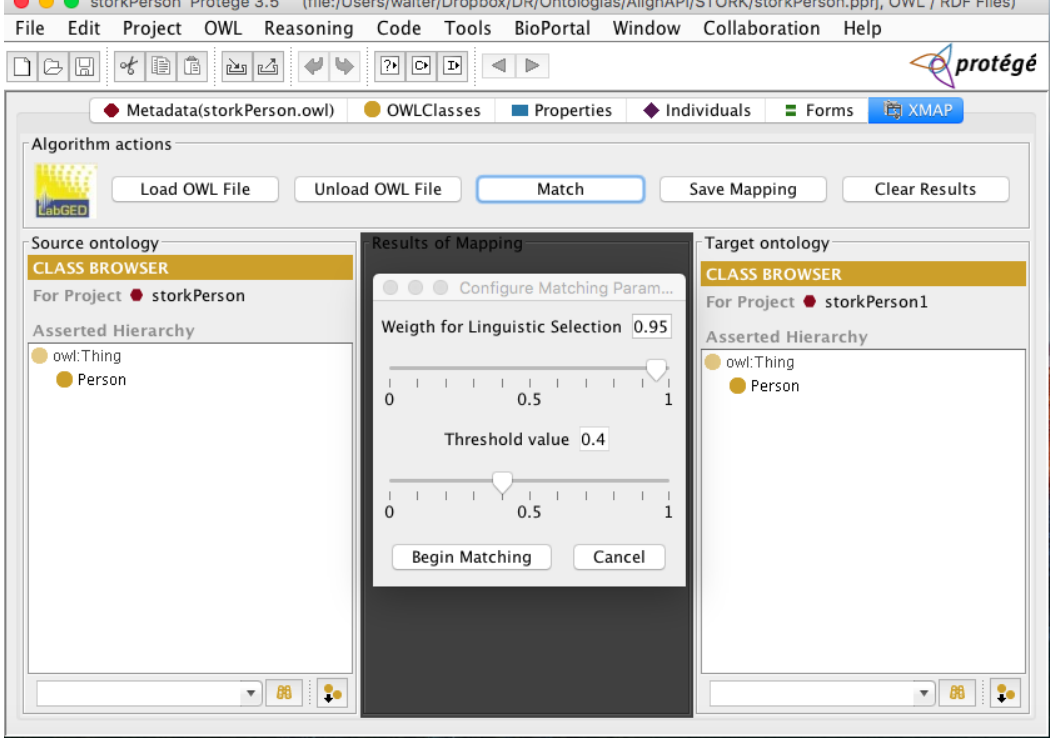
Figure 2. Main user interface of